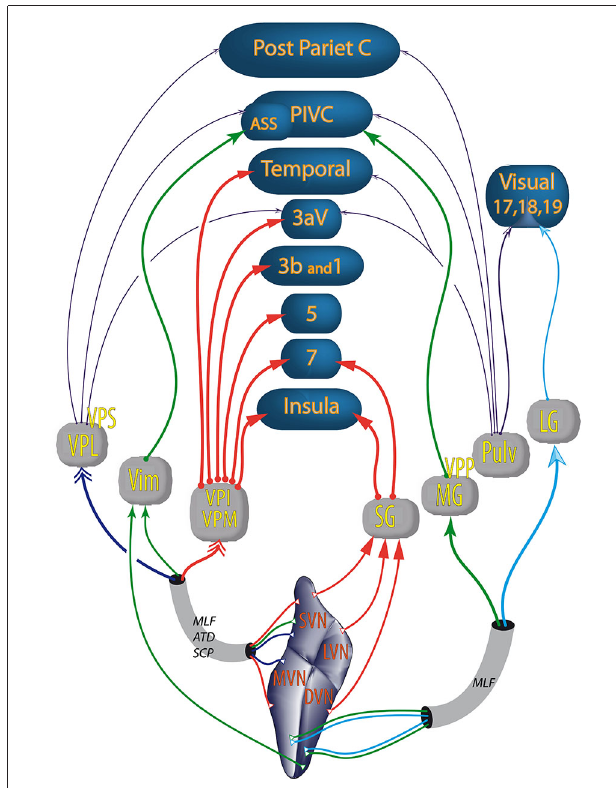
FIGURE 3 | Vestibular pathways to cortices through the thalamus . Colors of the arrows differentiate the thalamic nuclei. Double arrows ( → > ) correspond to bilateral projections. The other types and thickness of the arrows are varied to improve the readability of the figure; ATD, ascendant tractus of Deiters; ASS, anterior suprasylvian cortex (homolog in cats of the primate PIVC); DVN, descending vestibular nuclei; LG, lateral geniculate; LVN, lateral vestibular nuclei; MLF, medial longitudinal fasciculus; MG, medial geniculate nucleus; MVN, medial vestibular nuclei; PIVC, parieto insular vestibular cortex (in primates); Post Pariet C, posterior parietal cortex; Pulv, pulvinar; SG, suprageniculate nucleus; SCP, superior cerebellar pedunculus; SVN, superior vestibular nuclei; Temporal, temporal cortex; Vim, nucleus ventralis intermedius; VPI, ventral posterior inferior nucleus; VPL, ventral posterior lateral nucleus; VPM, ventral posterior median nucleus; VPP, nucleus ventralis posterior pars posterior; VPS, ventral posterior superior nucleus; numbers (e.g., 5 or 3b) refer to Brodmann areas. From studies in rodents, cats and primates (Nagata, 1986; Akbarian et al., 1992; Reep et al., 1994; Marlinski and McCrea, 2008; Lopez and Blanke, 2011).